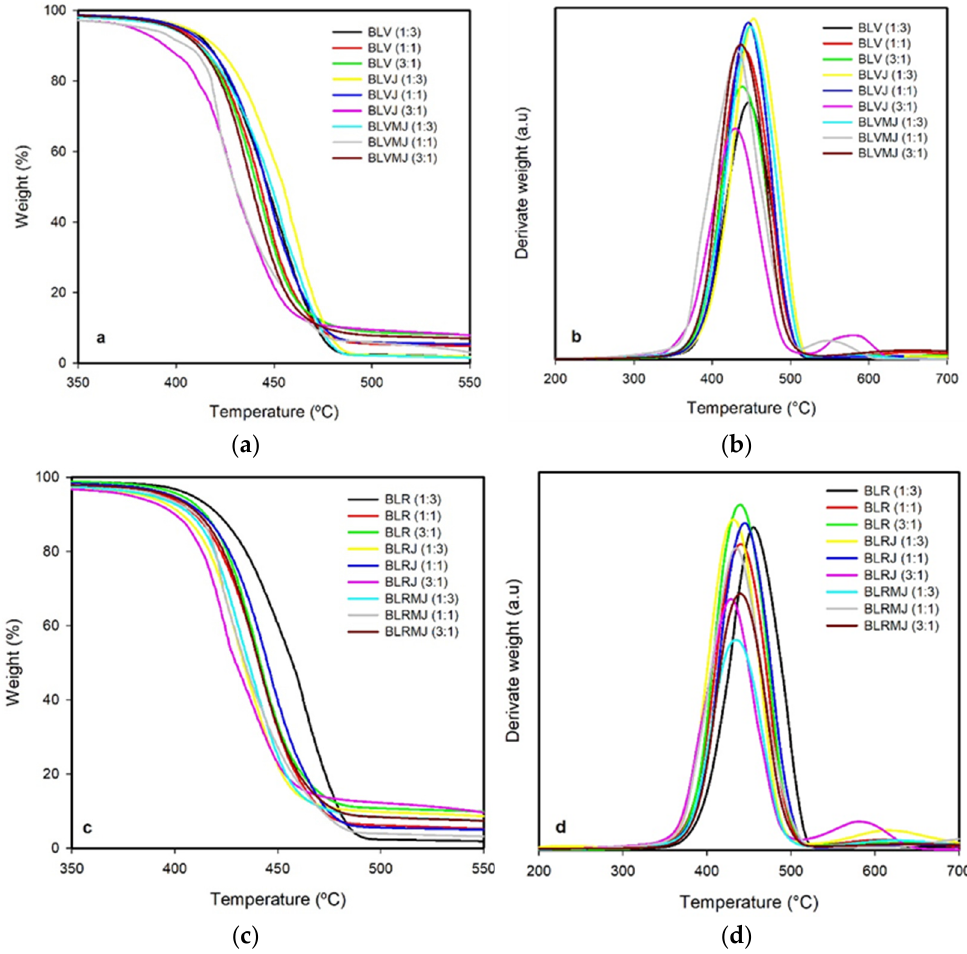
Figure 7. ( a – c ) Thermogravimetric (TGA) and ( b – d ) TGA derivative (DTG) curves for the neat, additivated and compatibilized and additivated PETV/HDPE and PETR/HDPE